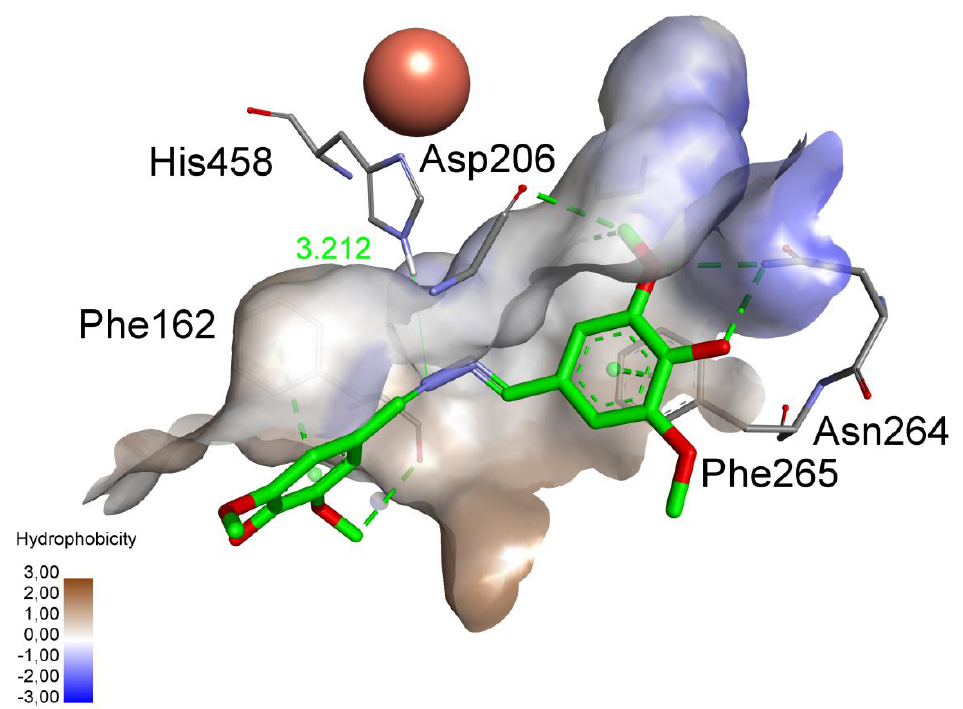
Figure 4. Structure of laccase enzyme from Trametes versicolor (PDB: 1GYC) with the syringaldazine in the active substrate centre. The interactions are shown as green dashed lines. The distance of the ligand to His-458 is 3.212 Å and is shown as regular green line. The copper ion (type 1) is shown as an orange sphere.